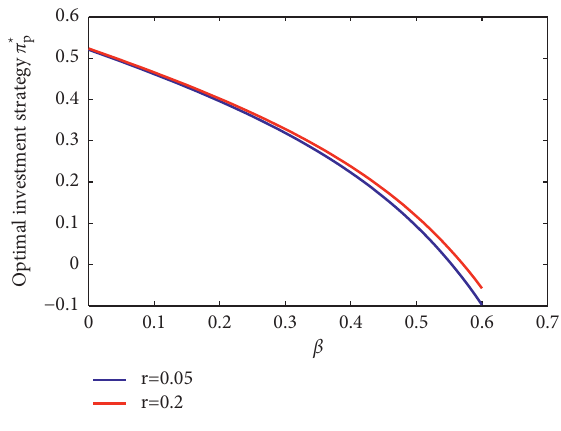
Figure 1: The effects of β on π ∗